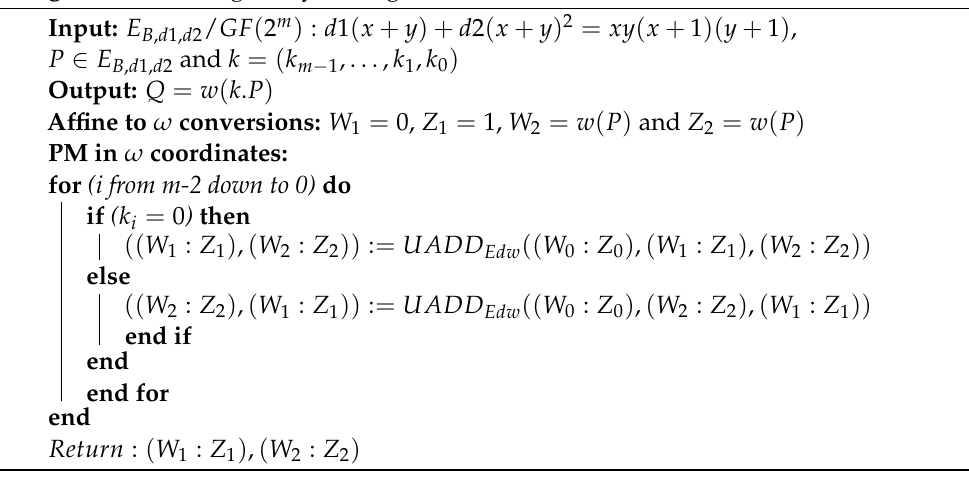
Algorithm 2: Montgomery PM algorithm for Edward curve [16].